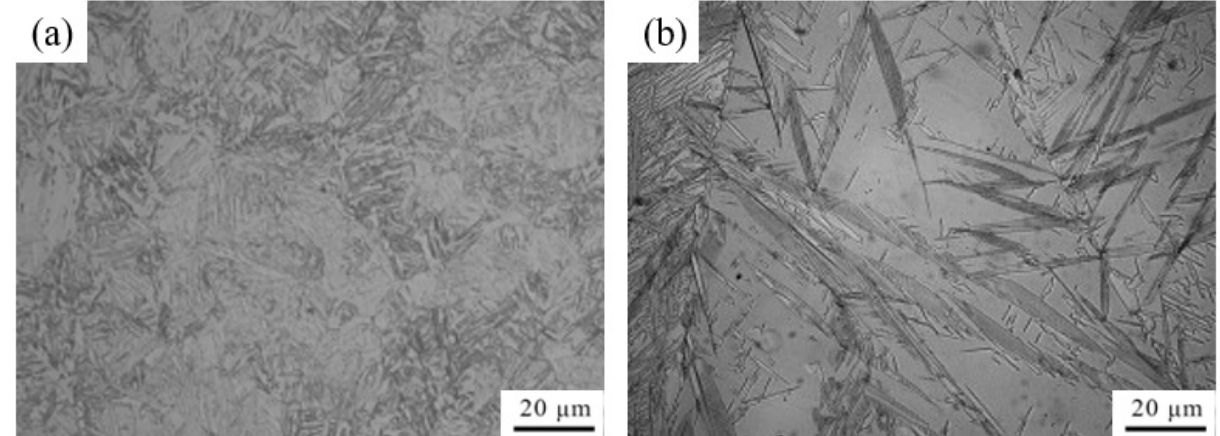
Figure 1. Martensites in alloys [25]: . ( a ) Lath martensitein Fe-14Mo-11.5Cr-9Ni-7Co-2Cu-0.6Ti- 0.4Al(weight %) alloy austenitized at 1150 °C , and then quenched to room temperature in water, ( b ) Plate martensite in Fe-0.47Cr-0.27Si-0.22Mn-1.67C(weight %) alloy austenitized at 1100 °C , and then quenched in brine. Reprinted with permission from Ref. [25]. Copyright 2013 Elsevier.